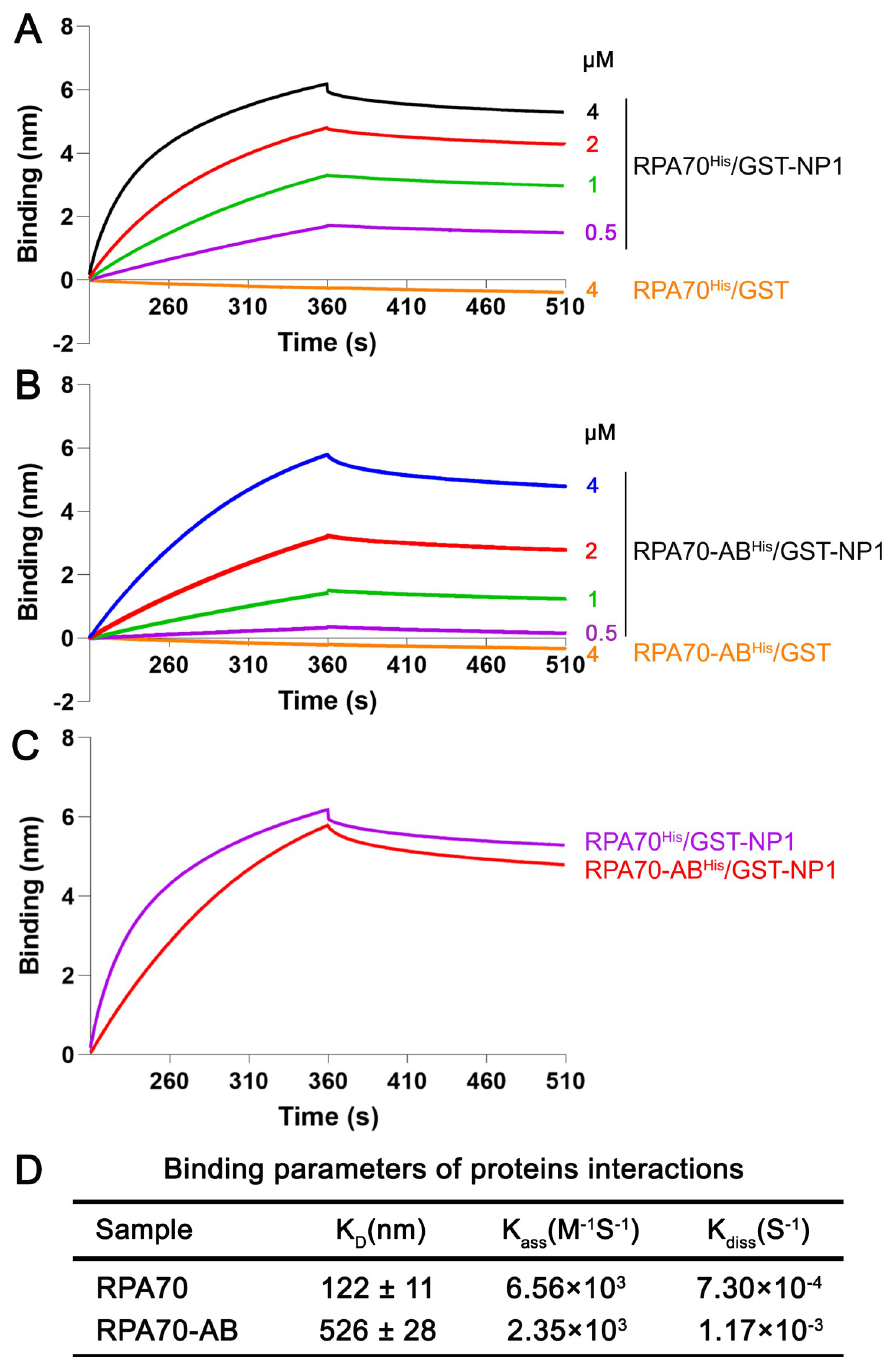
Fig 8. BLI analysis of the interaction between RPA70 and RPA70-AB with HBoV1 NP1. (A-B) Kinetic assays using Ni-NTA biosensors. The binding kinetics of associations and dissociations of 4 μ M GST-NP1 with RPA70 His (A) and RPA70-AB His (B) at different indicated concentrations are shown, together with controls of 4 μ M GST with 4 μ M Ku70 His or MBP-Ku70- β -barrel His . (C) Comparison of the binding affinities. The binding kinetics of associations and dissociations of of RPA70 His and RPA70-AB His with GST-NP1 (all at 4 μ M). (D) Binding parameters of protein interactions. Equilibrium dissociation constant K D value represents the ratio of dissociation [K diss (S -1 )] and association [K ass (M -1 S -1 )] computed from the real-time binding curves of GST-NP1 to RPA70 His or RPA70-AB His . The K D values are shown with means ± standard deviations based on at least three repeated experiments.